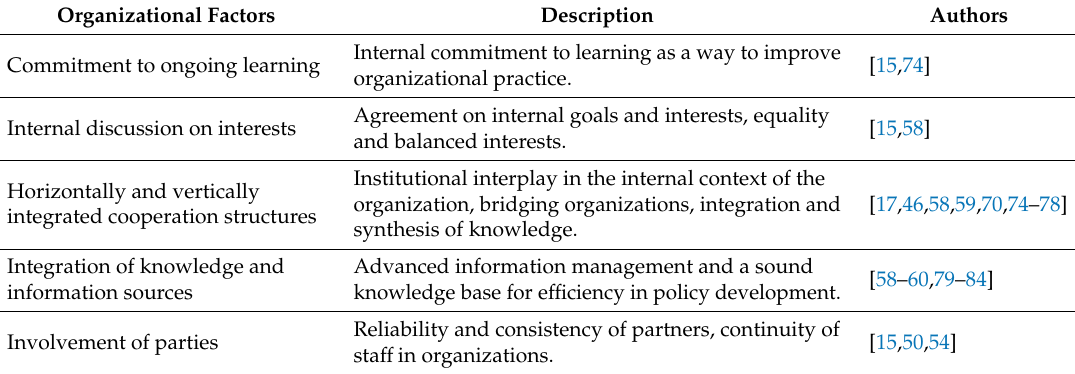
Table 3. Organizational factors that influence the social learning process.